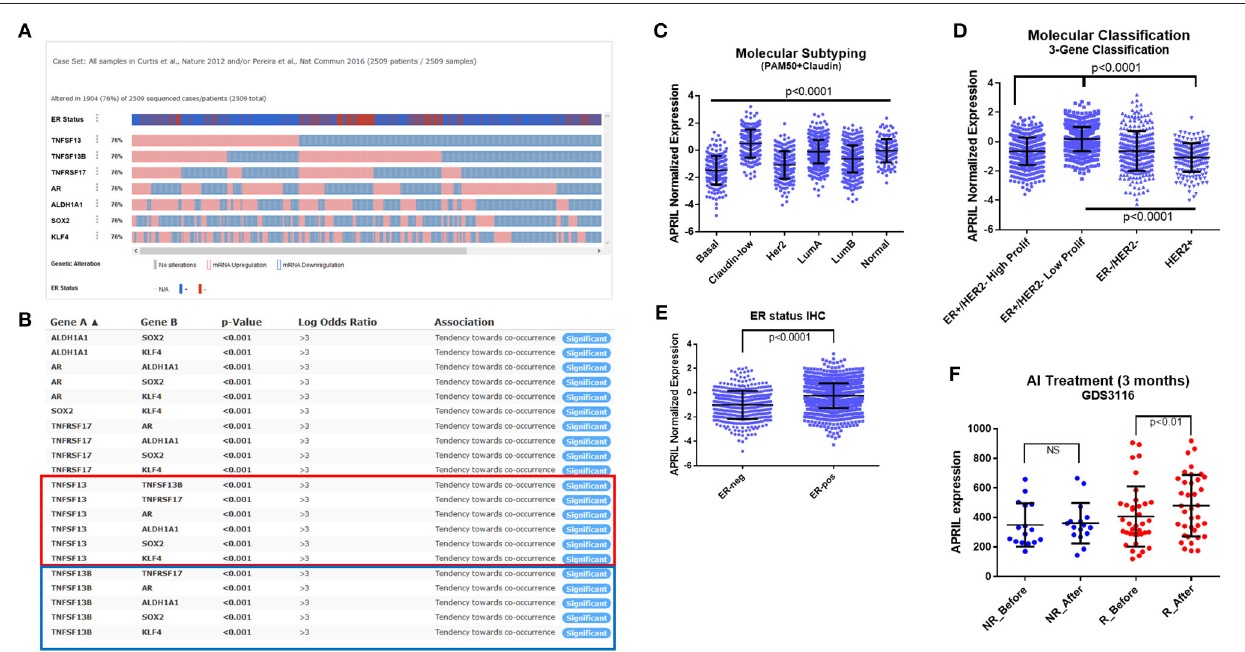
FIGURE 6 | APRIL expression in breast cancer specimens . Analysis of the MetaBRIC (23, 24) study (A-E) , in the cBioPortal (25–27) web environment. (A) Normalized expression of APRIL (TNFSF13), BAFF (TNFSF13B), BCMA (TNFRSF17), androgen receptor (AR) and the pluripotency genes ALDH1A1, SOX2, and KLF4. The IHC ER positive (red) and negative (blue) cases is also depicted. (B) Co-expression analysis of the genes presented in A, performed in c-BioPortal. The red box presents APRIL and the blue one BAFF co-occurrence analysis. (C–D) . Analysis of molecular classification of the MetaBRIC study for normalized APRIL expression, according to the PAM50 + claudin and the 3-gene metagene. (E) Analysis of normalized APRIL expression in IHC ER status of the MetaBRIC patients. (F) Analysis of APRIL expression in the letrozole GDS3116 study ( 28, 29), according to the patients’ response to a 14 days-treatment. Data from non-responders (NR, blue) and responders (R, red) are depicted, before and after letrozole treatment. See Material and Methods and Results sections for additional details. Data in panels (C–F) are analyzed by GraphPad Prism and depicted as individual values and mean ± SD. Statistical analysis was performed by ANOVA with post-hoc Turkey test in panels (C,D,F) , and Student’s T-test in panel (E)